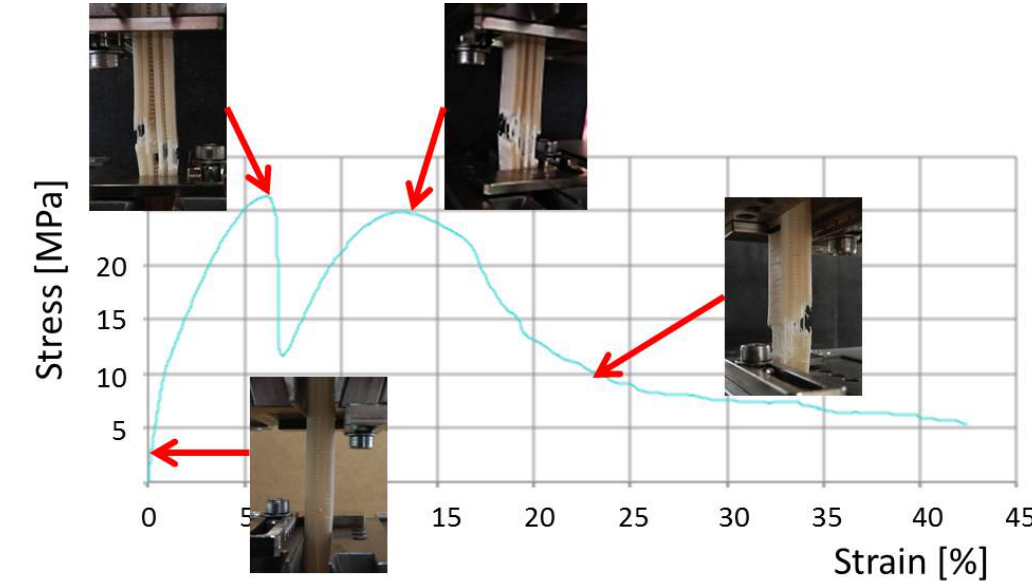
Figure 8. A typical tensile stress-strain curve with photographs depicting the development of damage in the cellular nano-composite beam with convex porosity gradient. The beam was cut longitudinally to visualize cell layers with different cell size.